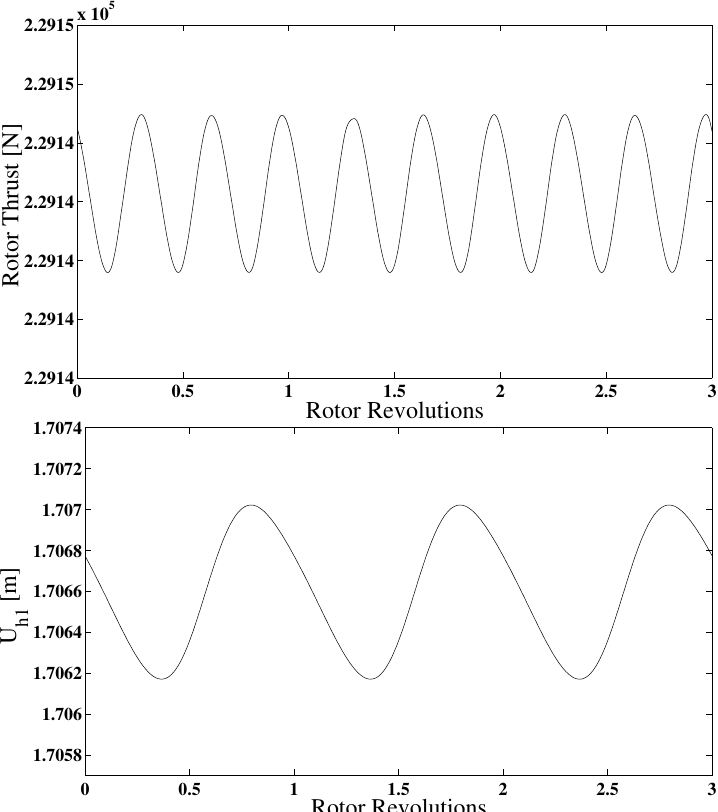
Figure 14. Rotor power, thrust, and displacement of the blade axis, for a section at 90% of the blade span for an NREL-5MW turbine rotating at its nominal speed of 12.1 rpm, with wind suddenly dropping to 5.8